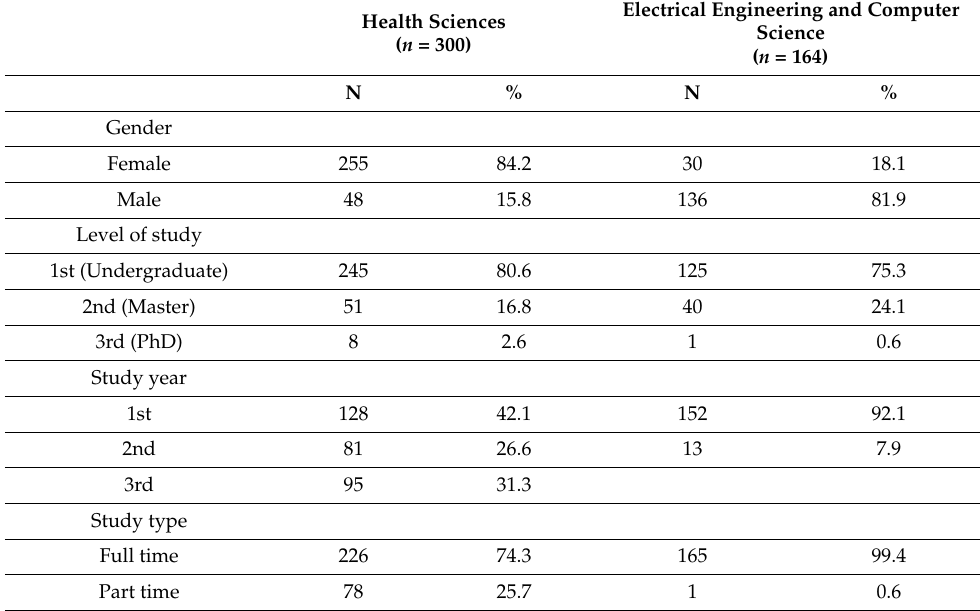
Table 1. Demographic characteristics of the sample by